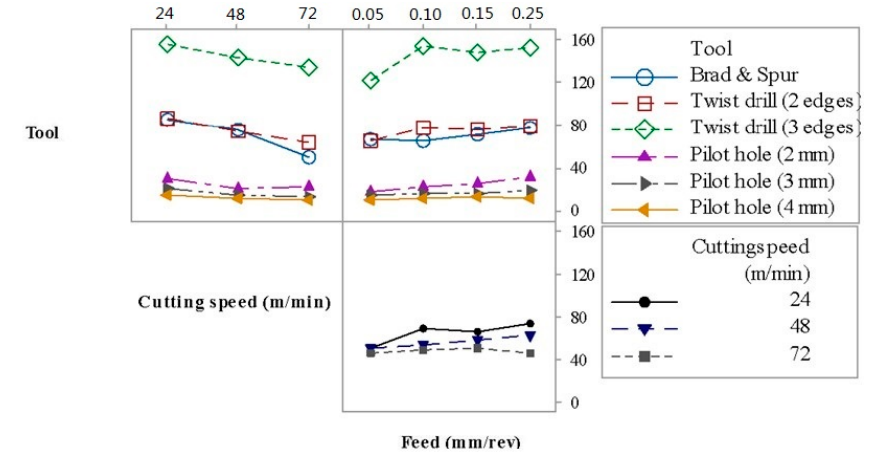
Figure 6. Interaction plot for thrust force.